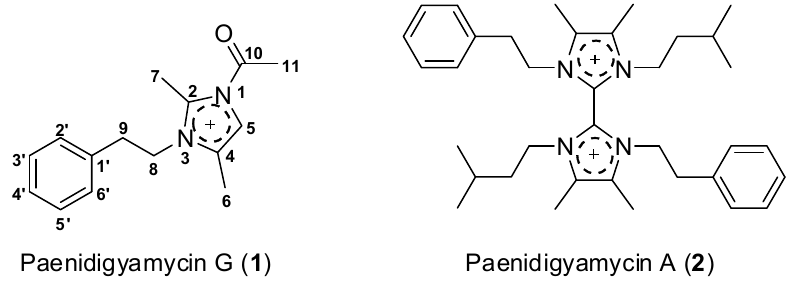
Figure 1. Structure of Paenidigyamycin G: 1-acetyl-2,4-dimethyl-3-phenethyl-1 H -imidazol-3-ium ( 1 ) and Paenidigyamycin A ( 2 ).